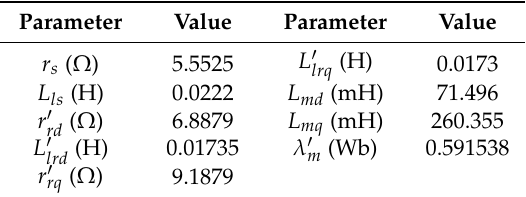
Table 9. Tested motor measured parameters.